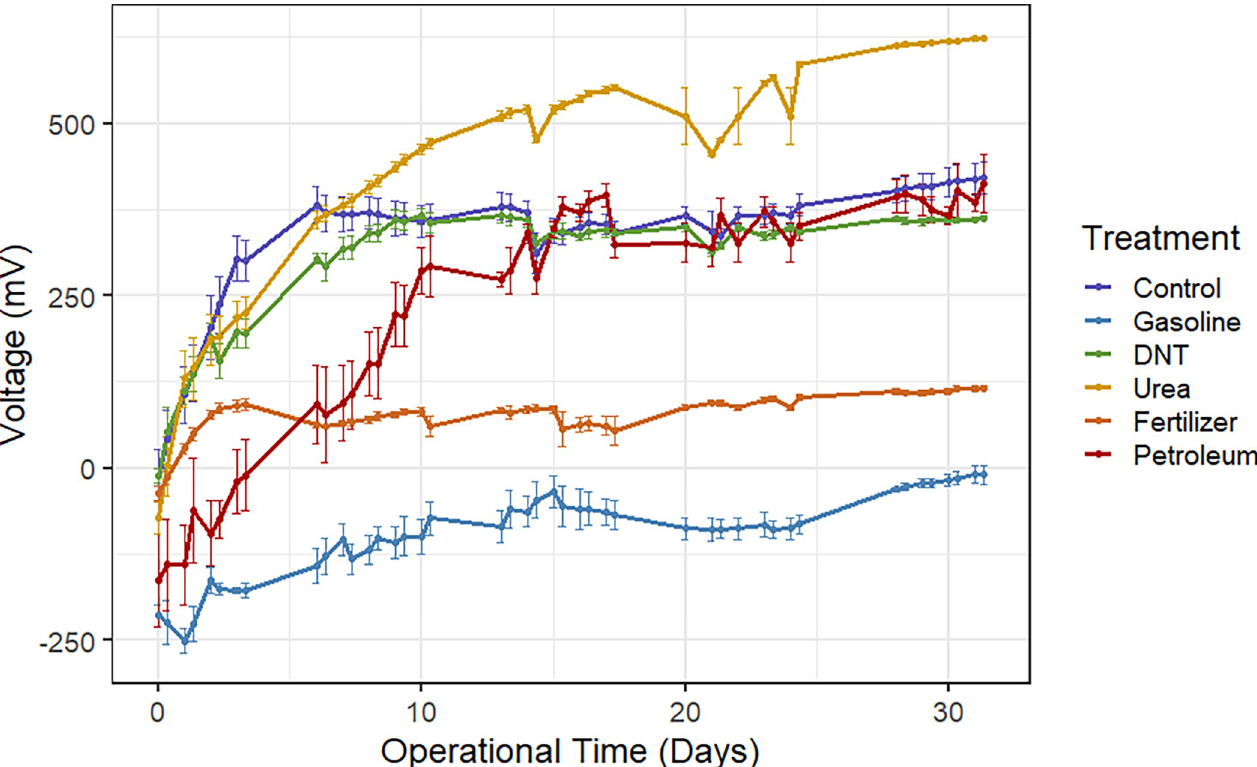
Fig 3. Evolution of voltage from tMFCs for the duration of the incubation. Lines indicate mean voltage. Bars indicate standard error of n = 6 replicates.